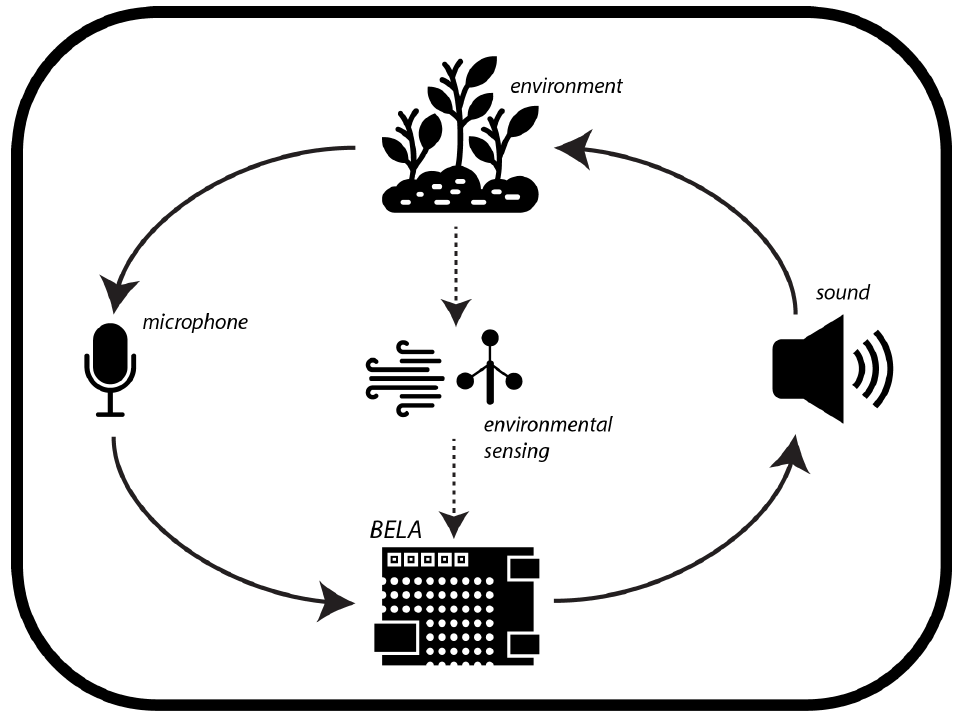
Figure 6. Signal flow of the garden bed